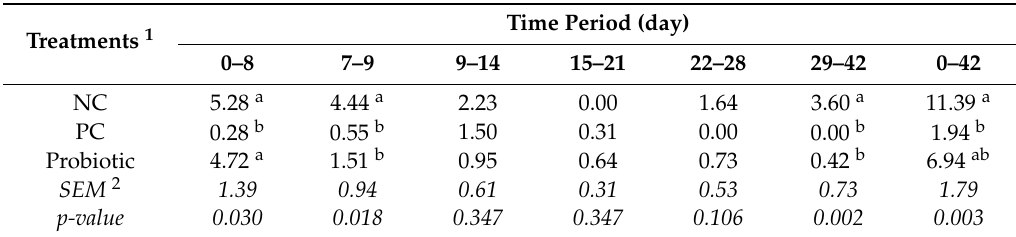
Table 3. E ff ect of antibiotic growth promoter or probiotic supplementation in the diet on mortality of broiler chickens under naturally occurring necrotic enteritis challenge.